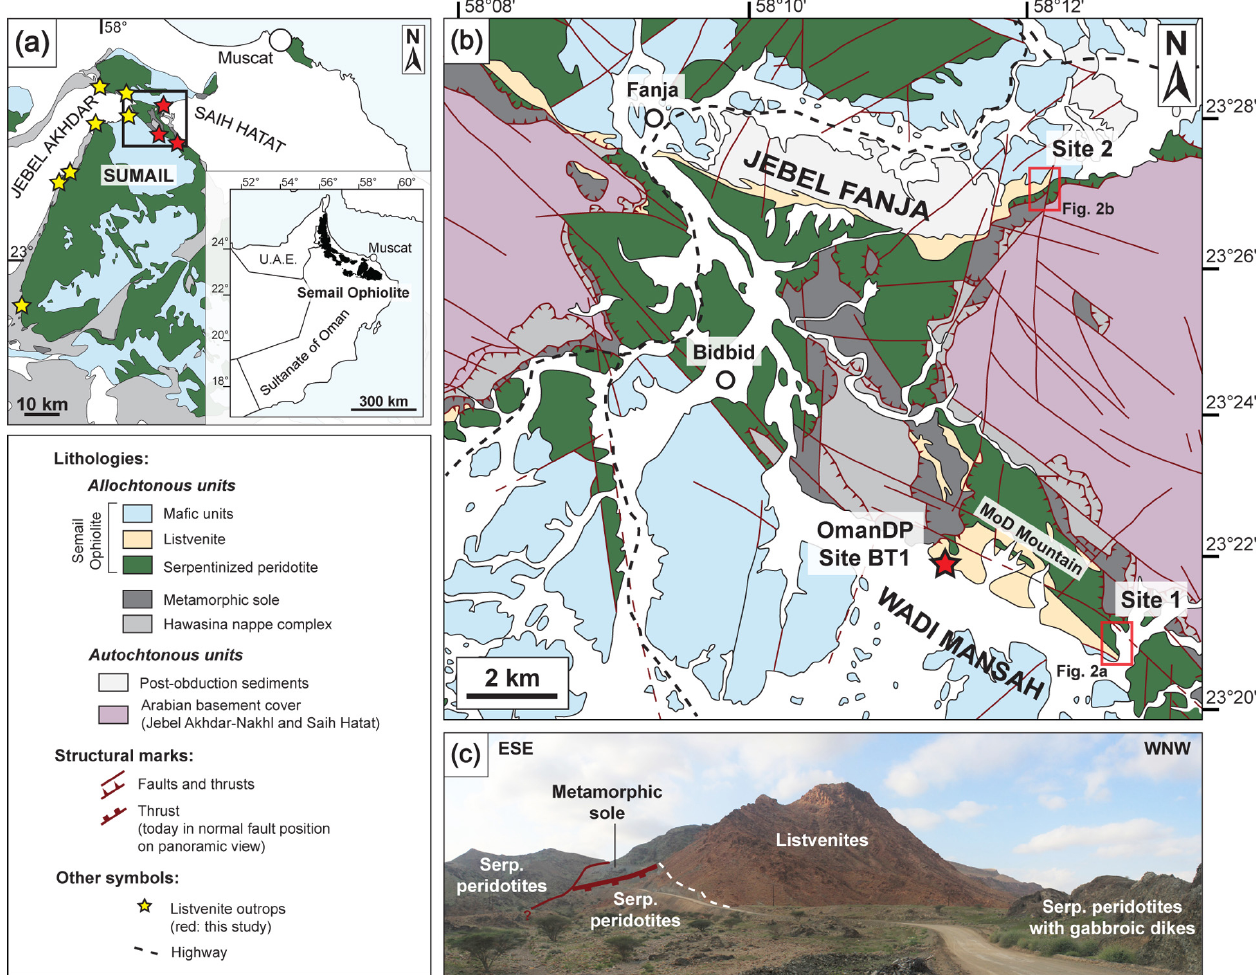
Figure 1. Listvenite outcrops in the Fanja area (Semail Ophiolite). (a) Location of the Semail Ophiolite in insert (based on Nicolas et al., 2000) and Sumail massif. Listvenite occurrences (yellow stars) are reported from Nasir et al. (2007) and Boudier and Nicolas (2018). (b) Geological map of the Fanja area (modified from Villey et al., 1986; Kelemen et al., 2022), indicated by a black rectangle in the insert map in (a) . (c) Field photograph of a lithological contact between listvenites and serpentinized peridotites at Site 2 (Jebel Fanja; PV in Fig.